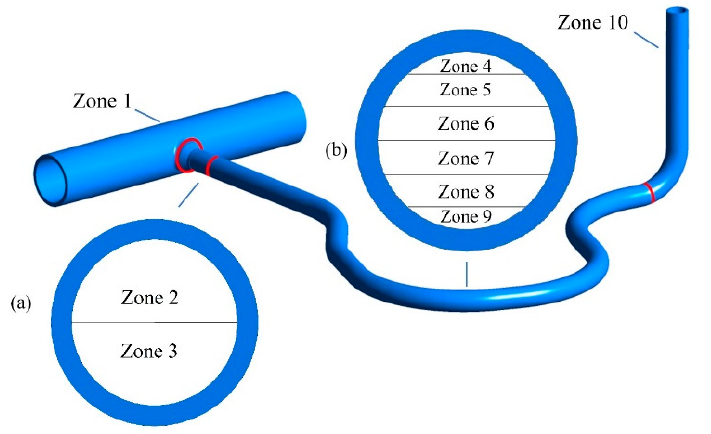
Figure 6. The division of thermal zones of the surge line. ( a ) Turbulent penetration region. ( b ) Thermal stratification region.